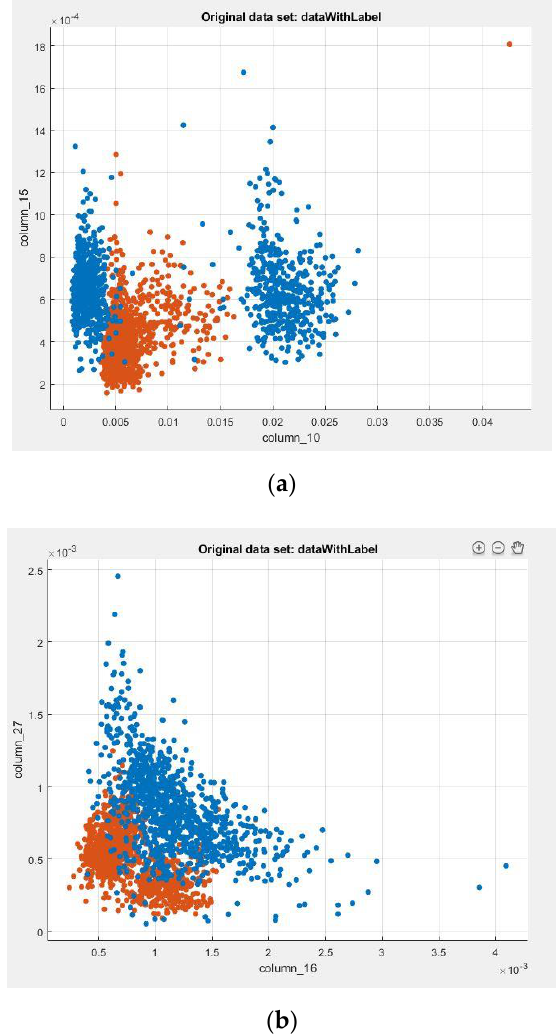
Figure 9. Scatter plot showing good versus faults data for some feature sets. ( a ) Scatter plot of good data; ( b ) Scatter plot of faulty data.